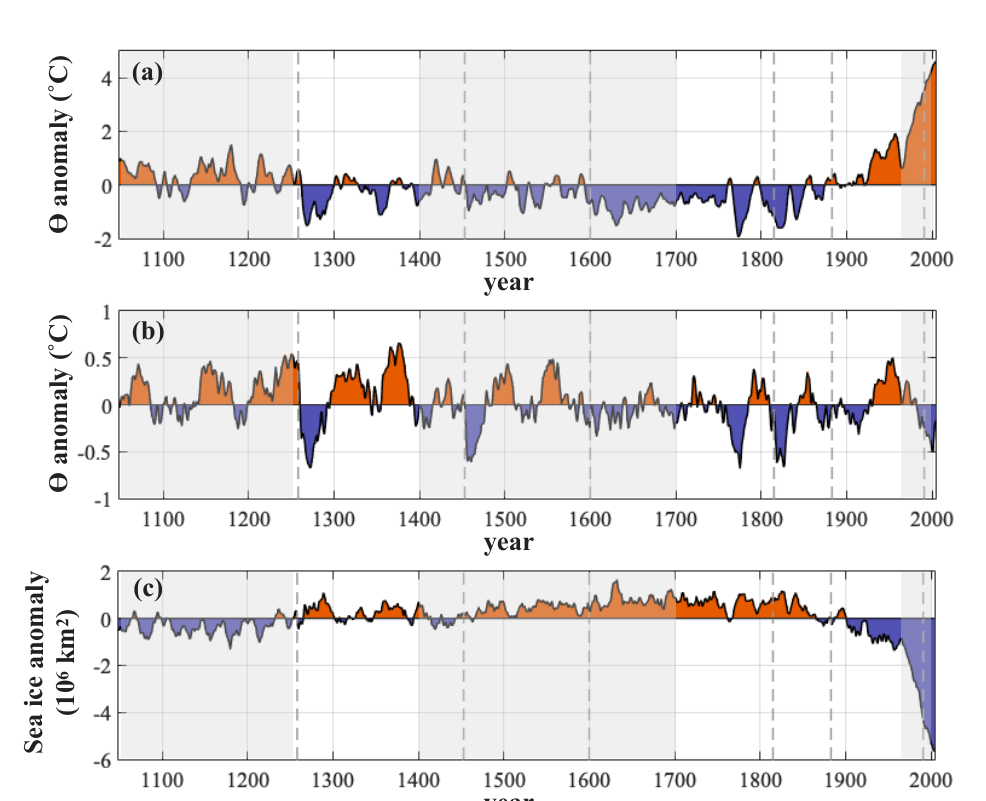
Figure 3. Time series of zonally averaged potential temperature anomalies along the WS transect and sea ice extent anomalies with respect to the full LME simulation period. ( a ) Vertically integrated surface layers (5–200m). In the same fashion, ( b ) refers to integrated subsurface layers (300–700m). ( c ) Horizontally averaged sea ice extent within the WS (50–90 ◦ S & 60 ◦ W–20 ◦ E). Anomalies are detrended and normalized by the standard deviation. Light gray shaded areas refer to the MCA, LIA and late 20th century, as in Figure 2. Dashed gray lines mark major volcanic eruptions: Samalas, 1258; Kuwae, 1453; Huaynaputina, 1600; Tambora, 1815; Krakatoa, 1883; Pinatubo,